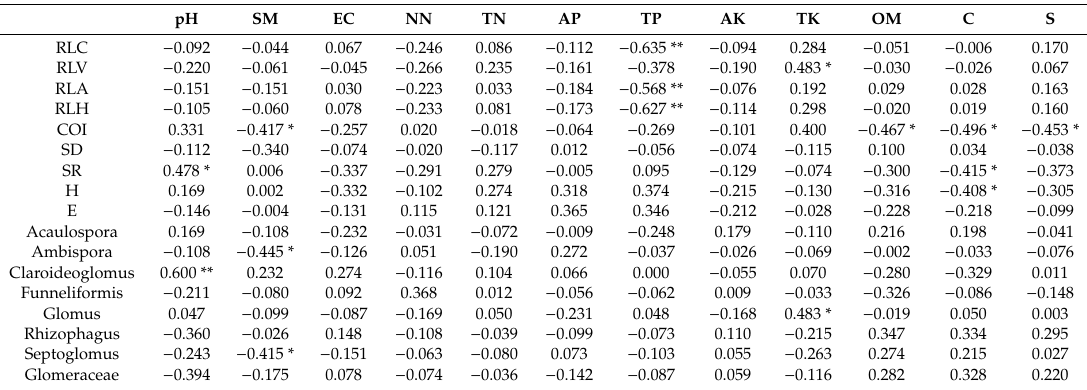
Table 5. Pearson’s correlation coe ffi cients between AMF community parameters and edaphic factors.